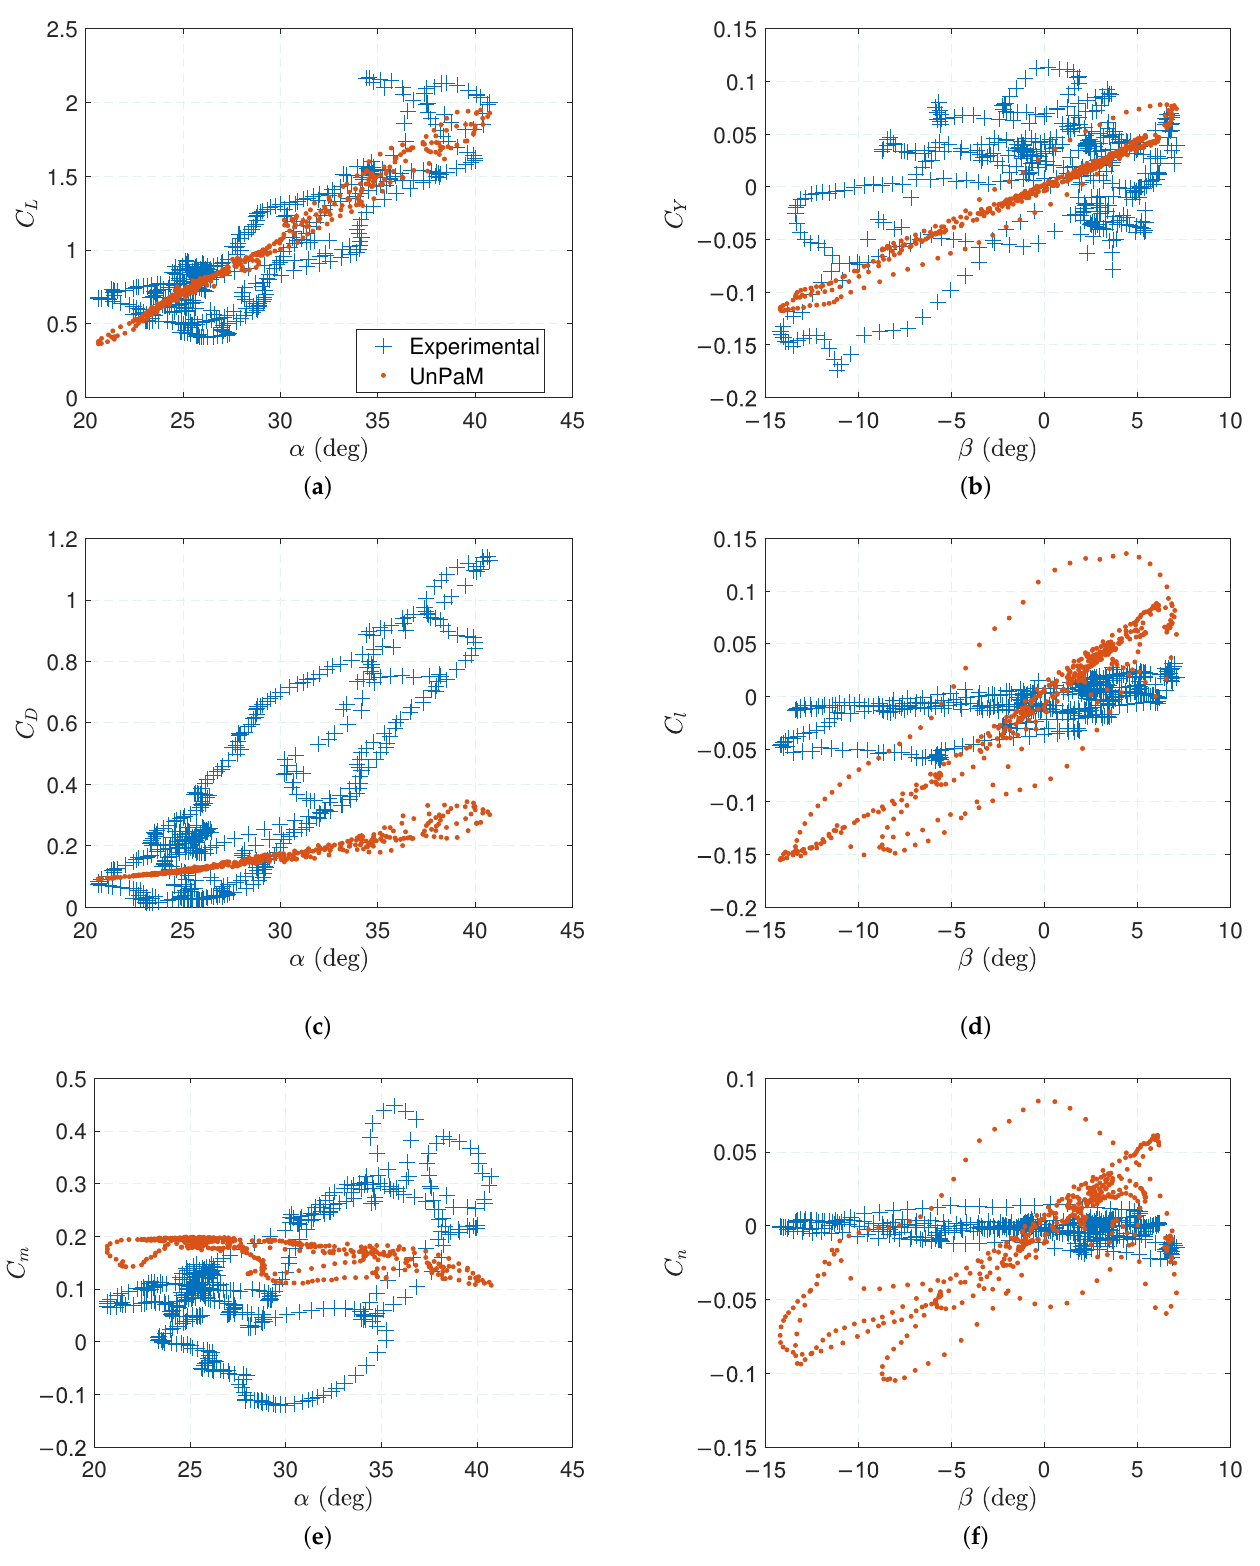
Figure 5. Force ( a – c ) for lift, lateral force and drag) and moment ( d – f ) for roll, pitch and yaw) coefficients comparison between UnPaM and experimental aerodynamic